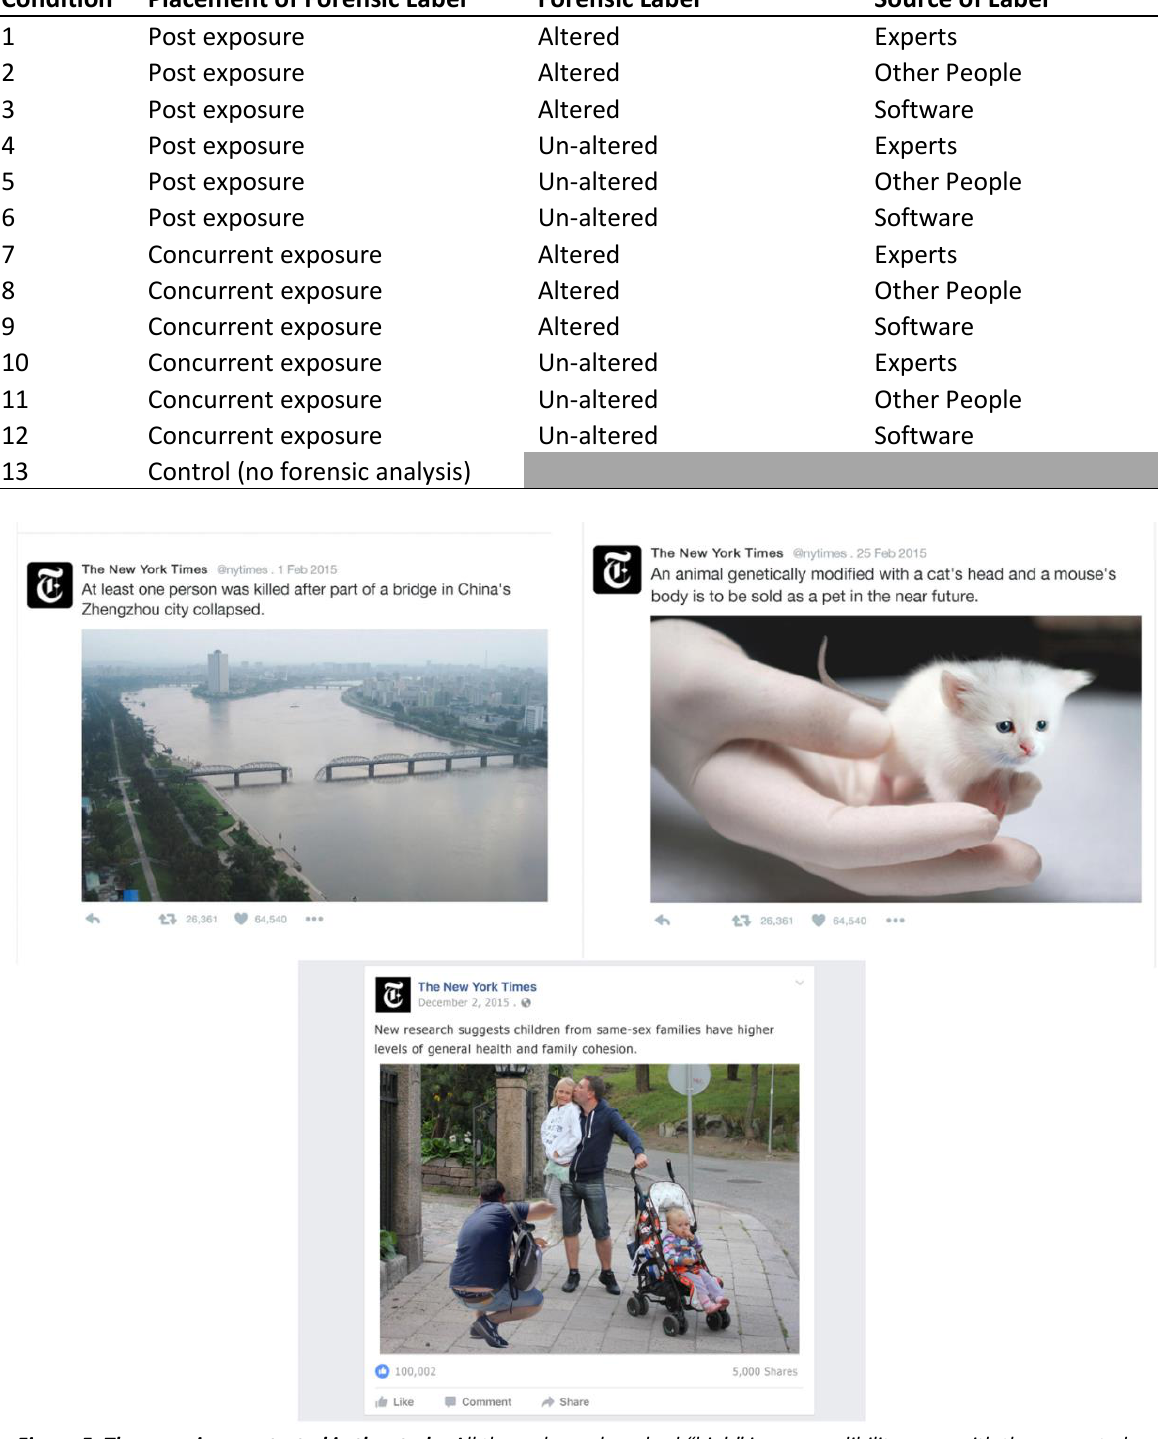
Table 1. Partial factorial experimental design with three factors: Image forensic label, source of forensic analysis, and placement of forensic label.